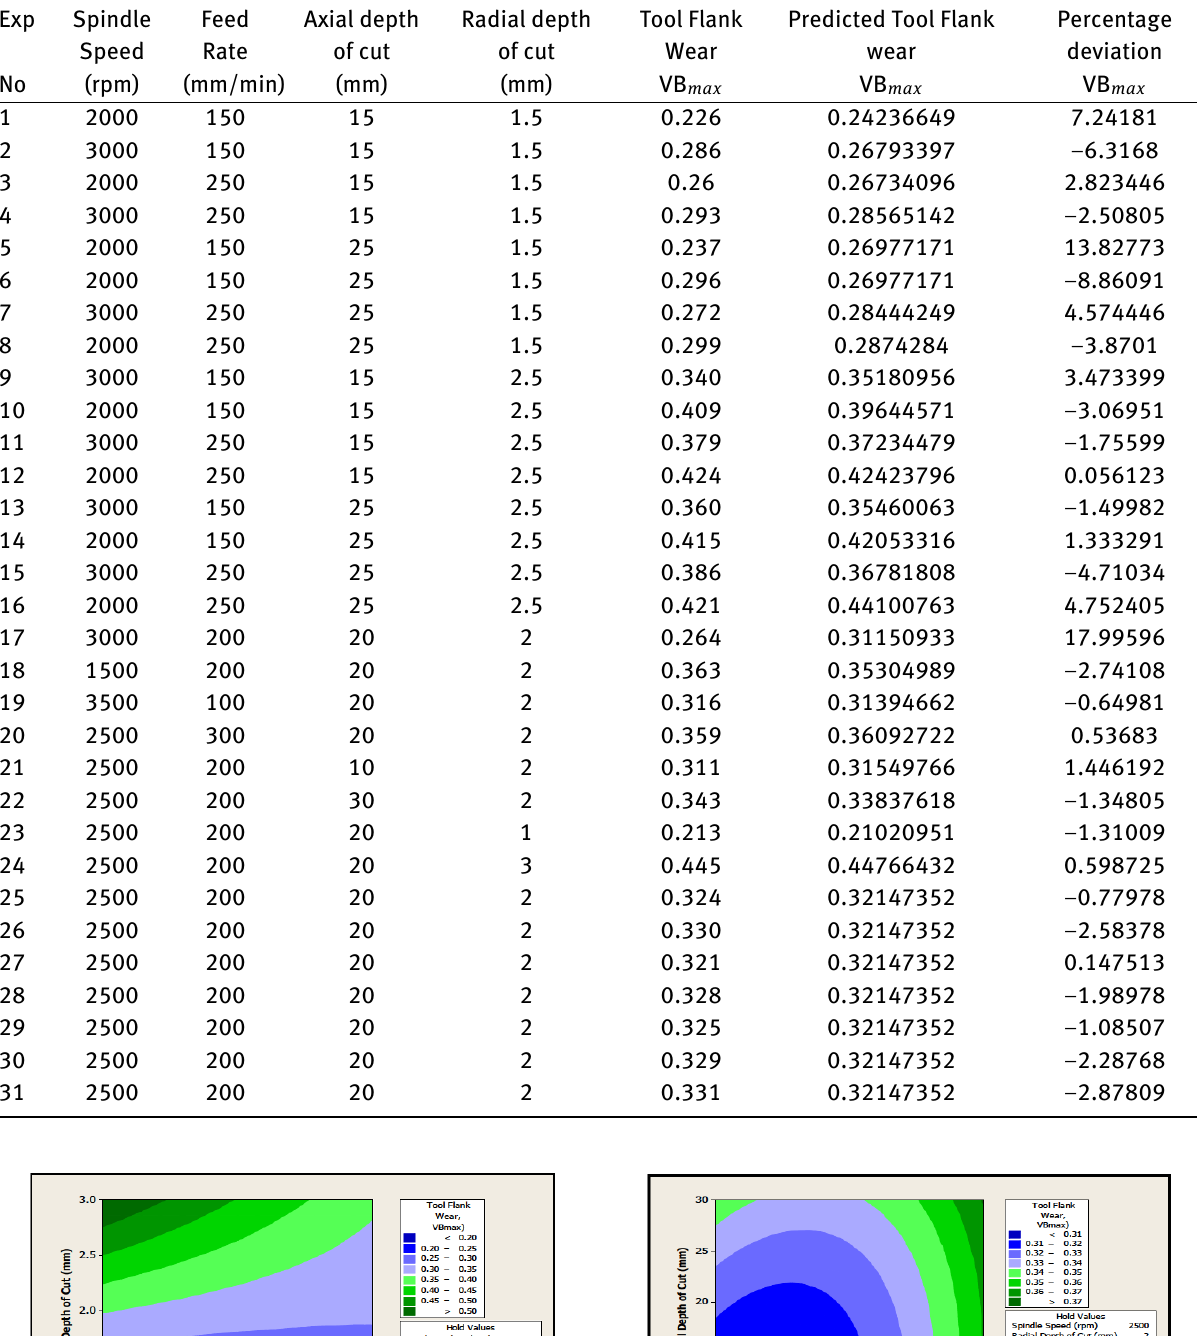
Table 7: Comparison between actual value and predicted value of tool wear (VB max ).